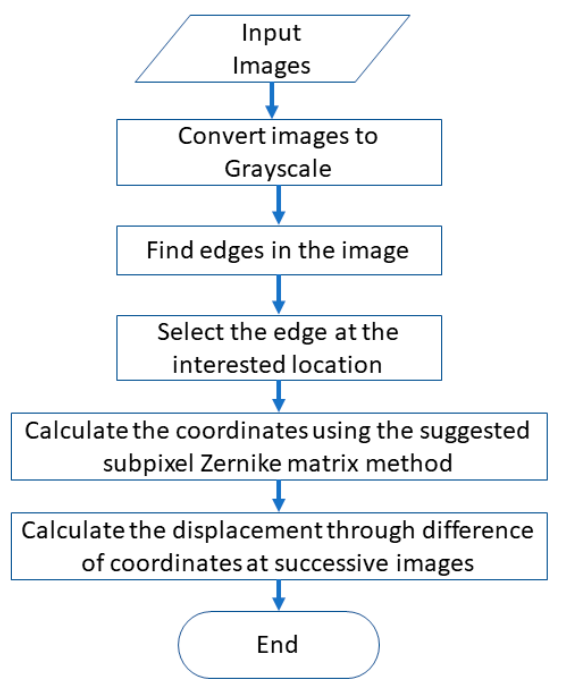
Figure 1. Flowchart of the proposed image-based vision sensor method.